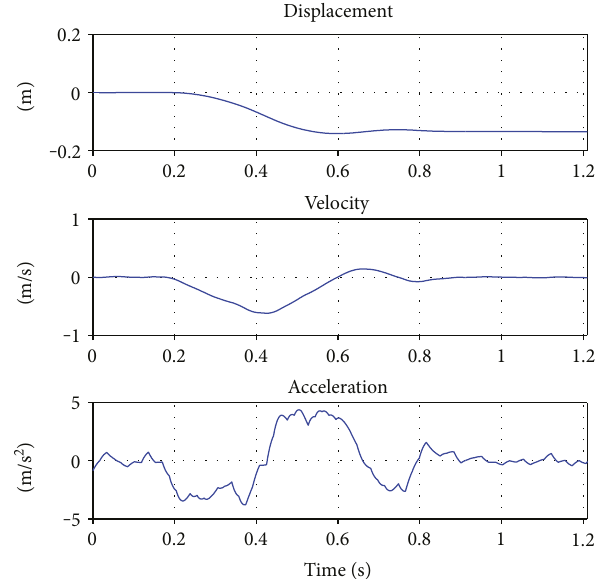
Figure 3: Filtered perturbation signal. For each trial, a qualitatively similar signal, containing change in position, velocity, and acceleration, was used. Quantitatively the perturbation signals di ff ered in direction, thus to the left or right and in displacement and